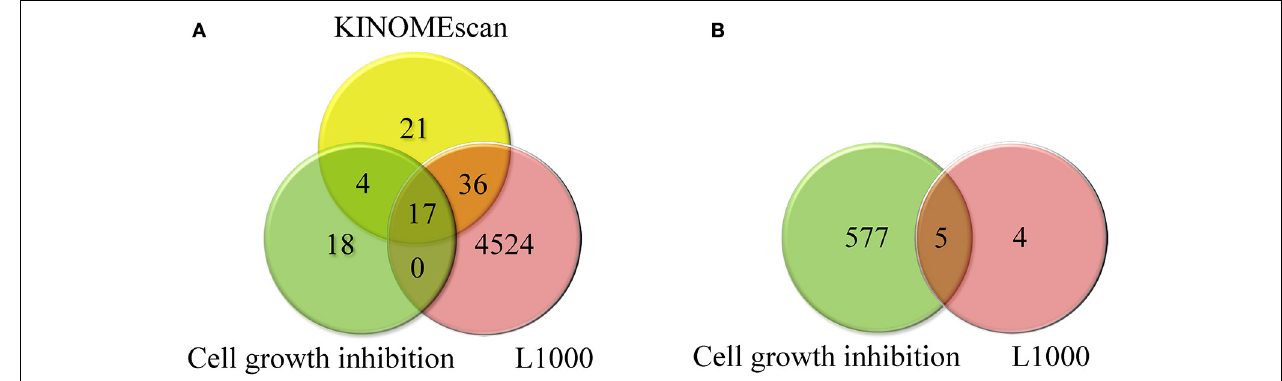
FIGURE 3 | (A) Overlap between compounds tested in KINOMEscan, cell growth inhibition, and L1000 assays and (B) overlap between cell lines tested in cell growth inhibition and L1000